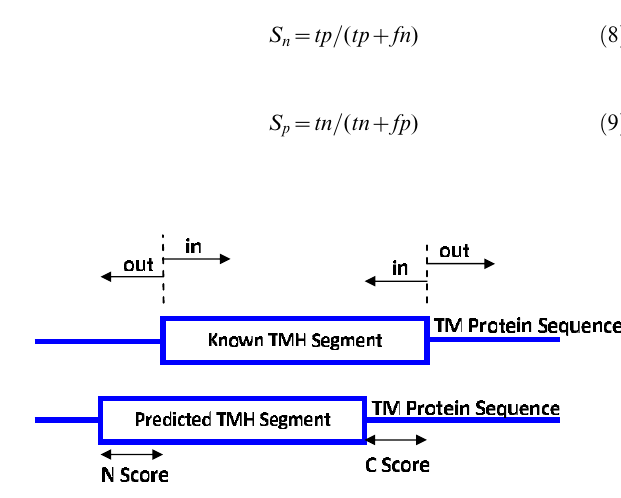
Figure 2. Encoding protein sequence as a chromosome.